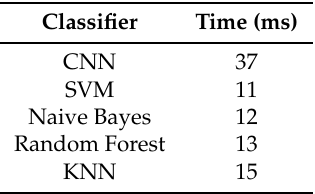
Table 7. Time consumption of different classifiers with periodic matching.